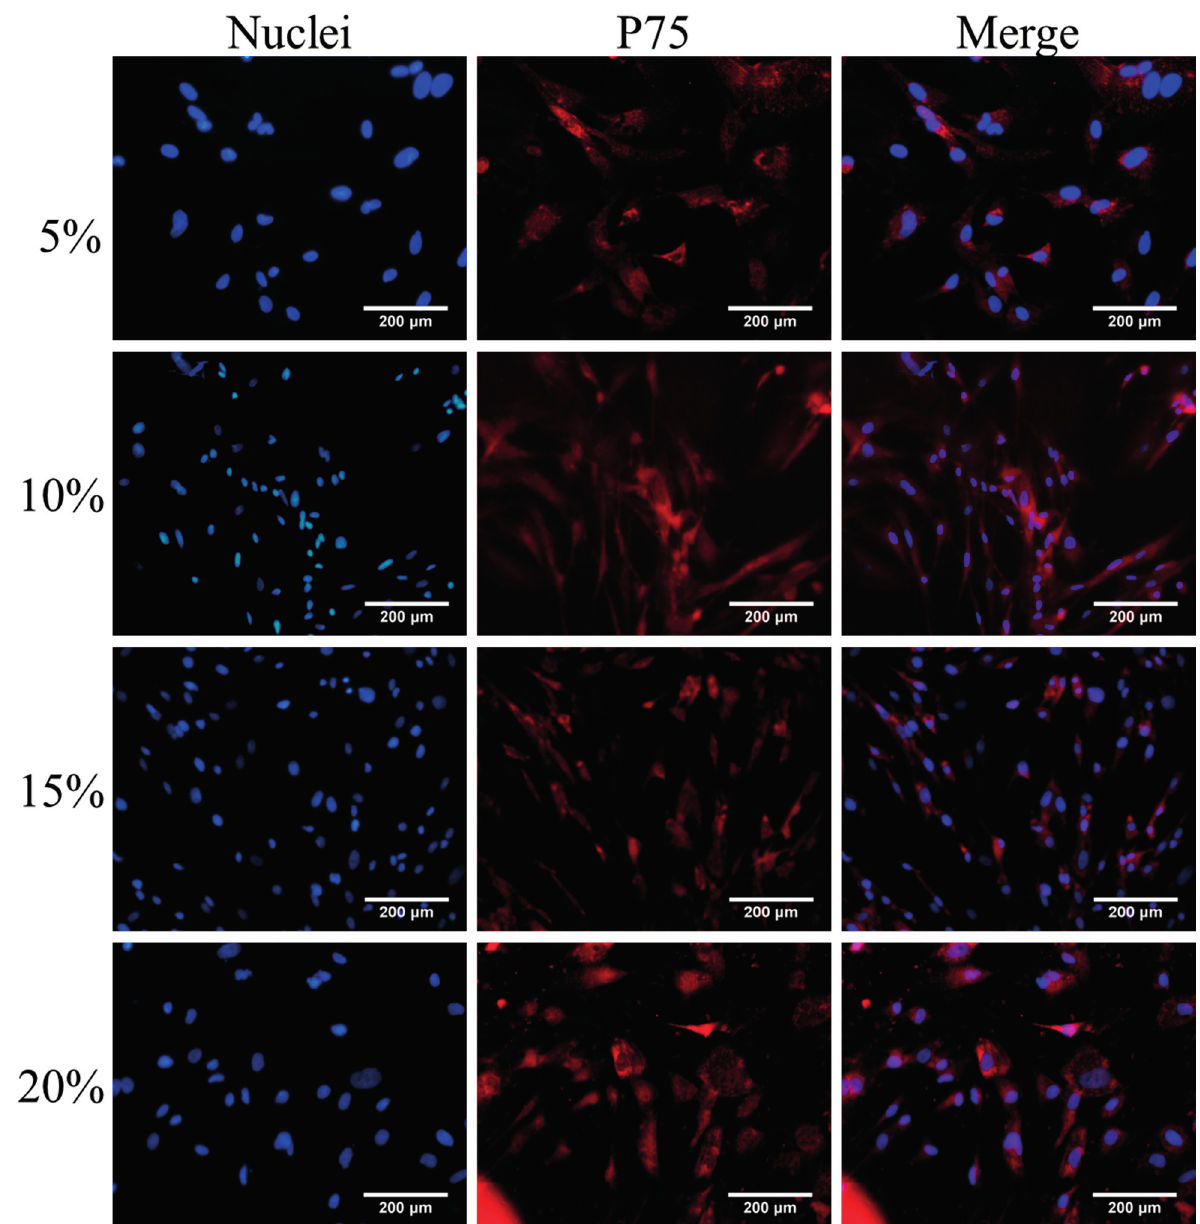
Figure 2. Immunofluorescence staining of OEC cultured in DF-12 medium containing rat serum (RS) (concentrations: 5%, 10%, 15%, 20%) for 7 days. The concentrations of RS are listed on the left. OEC nuclei stained with DAPI are presented in the left column, P75 of OEC stained with Cy3 are presented in the middle column, and the right column is the merged nuclei and P75. Scale bar is 200 μ